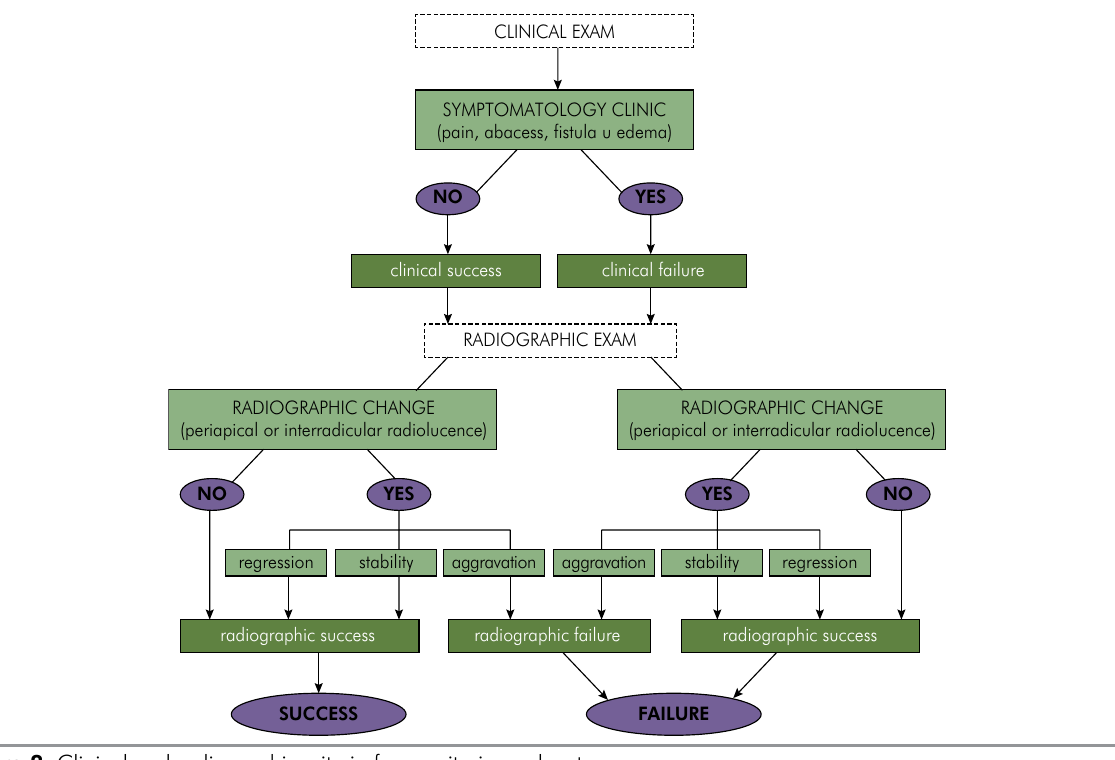
Figure 2. Clinical and radiographic criteria for monitoring pulpectomy.